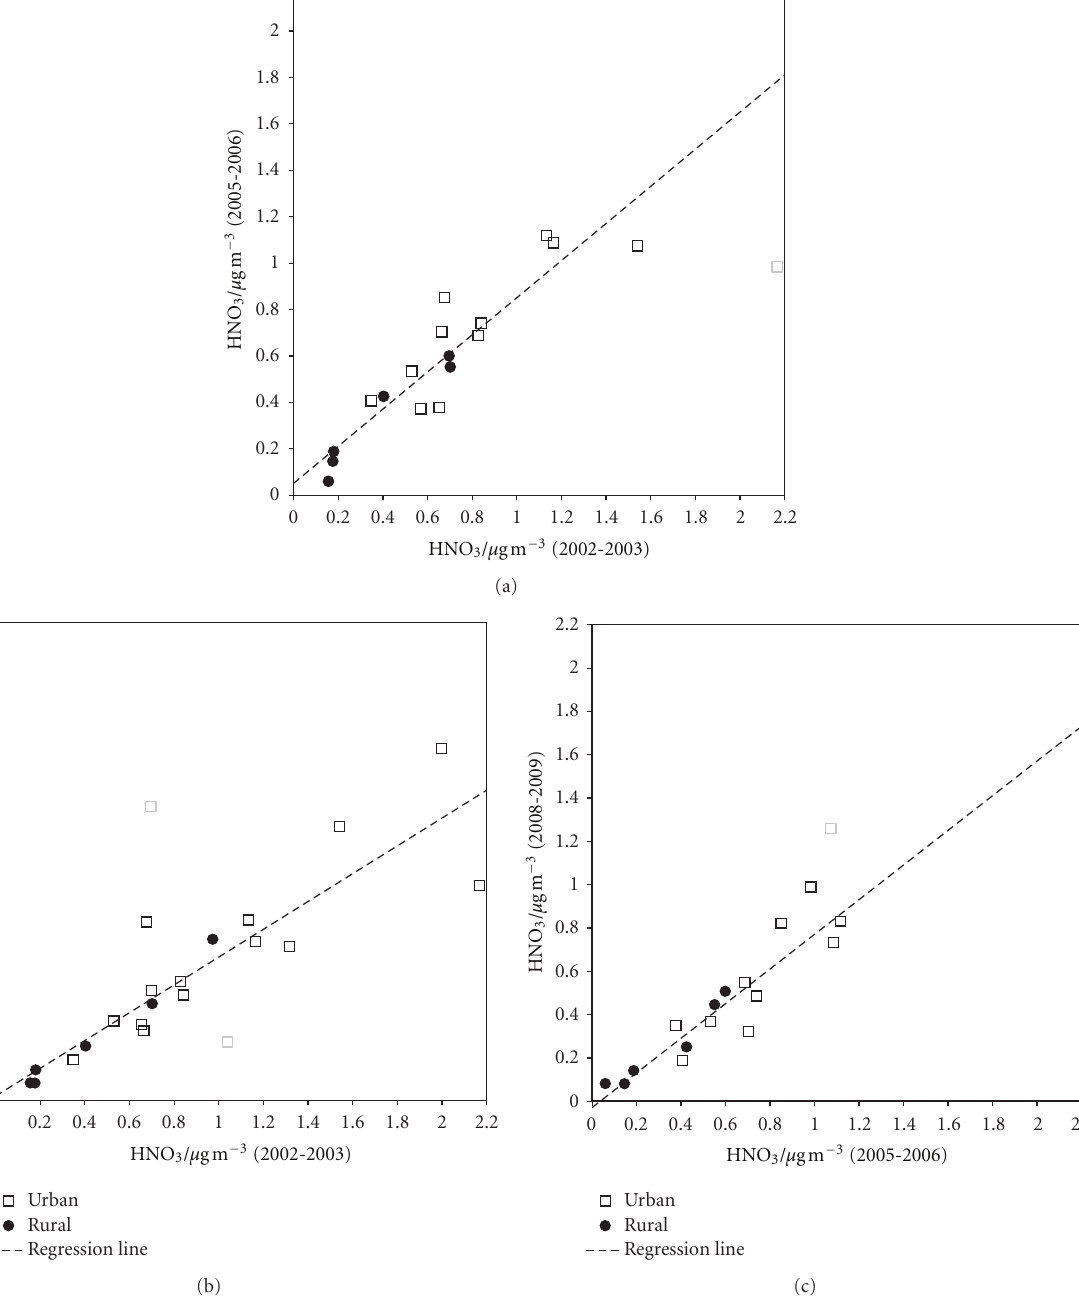
Figure 6: Annual average HNO 3 concentration at ICP Materials test sites for the three one-year campaigns 2002-2003, 2005-2006, and 2008-2009. The grey squares have been excluded when calculating the linear regression lines y = 0 . 80 x +0 . 05 (2005-2006 versus 2002-2003), y = 0 . 80 x − 0 . 03 (2008-2009 versus 2005-2006), y = 0 . 64 x + 0 . 02 (2008-2009 versus